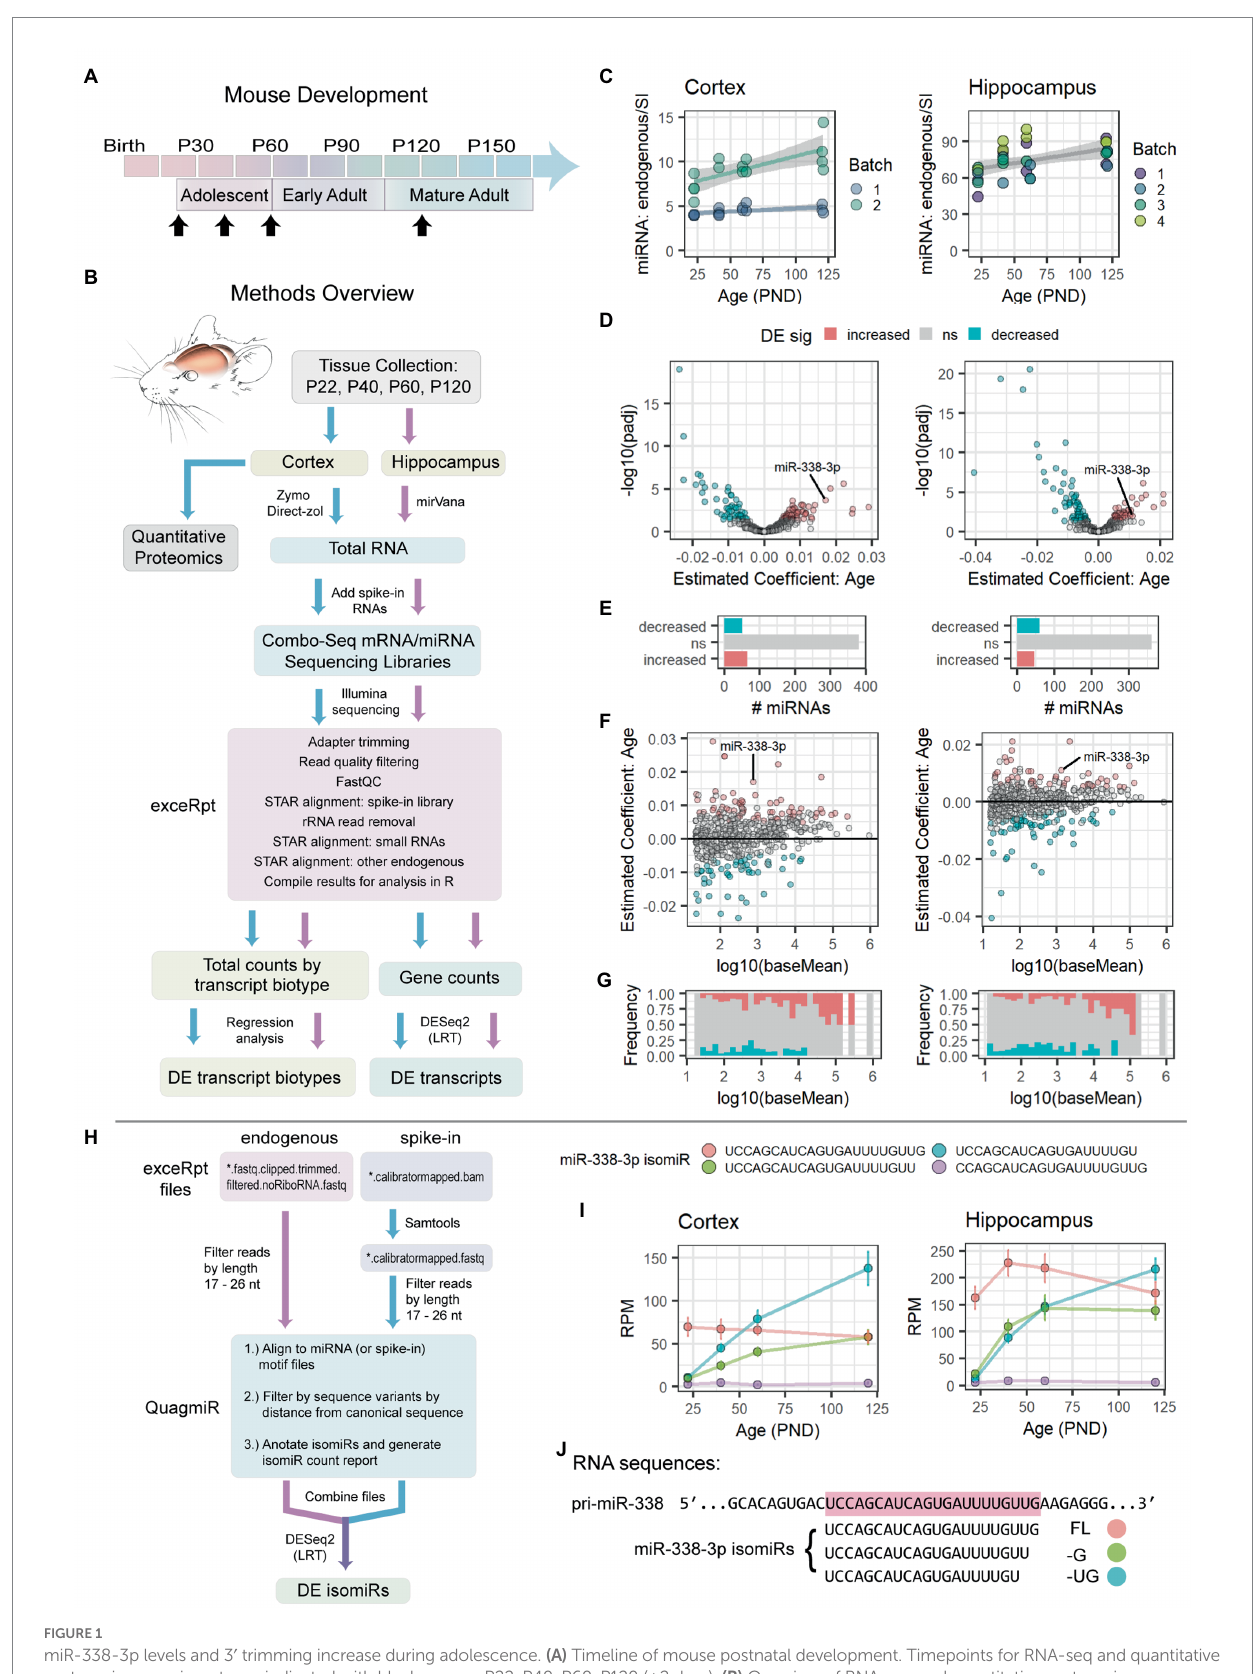
FIGURE 1 miR-338-3p levels and 3 ′ trimming increase during adolescence. (A) Timeline of mouse postnatal development. Timepoints for RNA-seq and quantitative proteomics experiments are indicated with black arrows: P22, P40, P60, P120 (±2 days). (B) Overview of RNA-seq and quantitative proteomics experiments. Mouse cortex and hippocampus were collected at the time points indicated in (A) . Approximately half of each cortical sample was used for quantitative proteomics experiments. Total RNA was extracted from remaining tissue and used to prepare combined mRNA/miRNA sequencing libraries (Combo-Seq). Large and small spike-in RNAs were added to each sample prior to library preparation. Following Illumina sequencing, data were analyzed